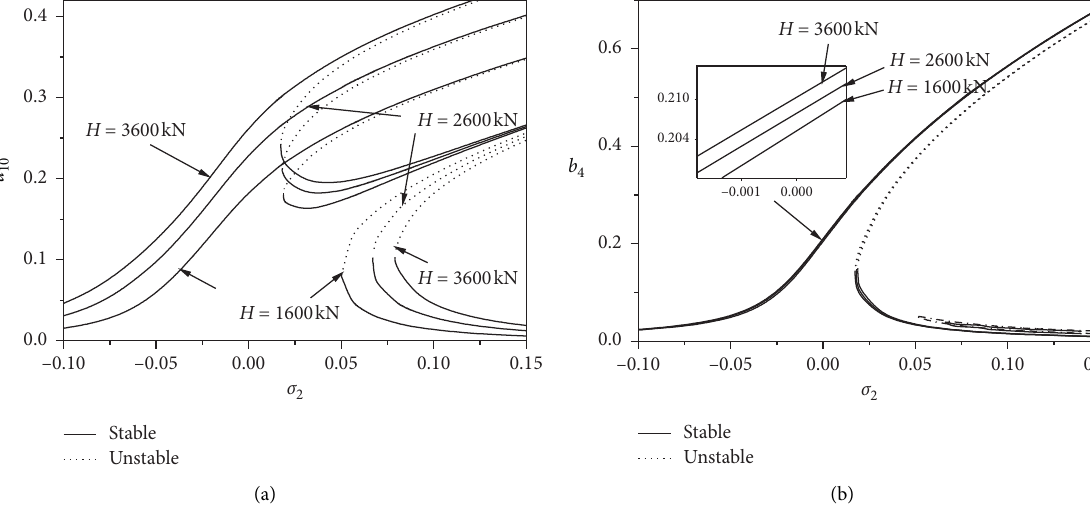
≈ ω and ω ≈ ω . 4 2 , 4 1 , 10 2 , 4